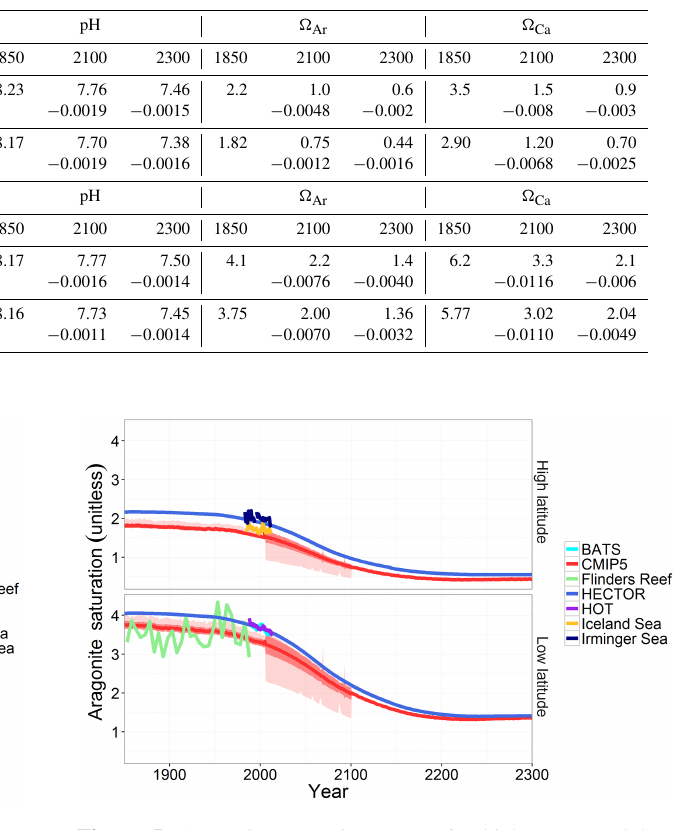
Figure 4. pH for high- (top) and low-latitude (bottom) surface ocean under RCP 8.5: Hector (blue), CMIP5 median, standard deviation, and model range (red, n = 13 (1850–2100) and n = 2; 2101–2300), as well as observations from BATS (teal), ESTOC (pink), HOT (pur- ple) Flinders Reef (green), Iceland Sea (yellow), and Irminger Sea (navy).